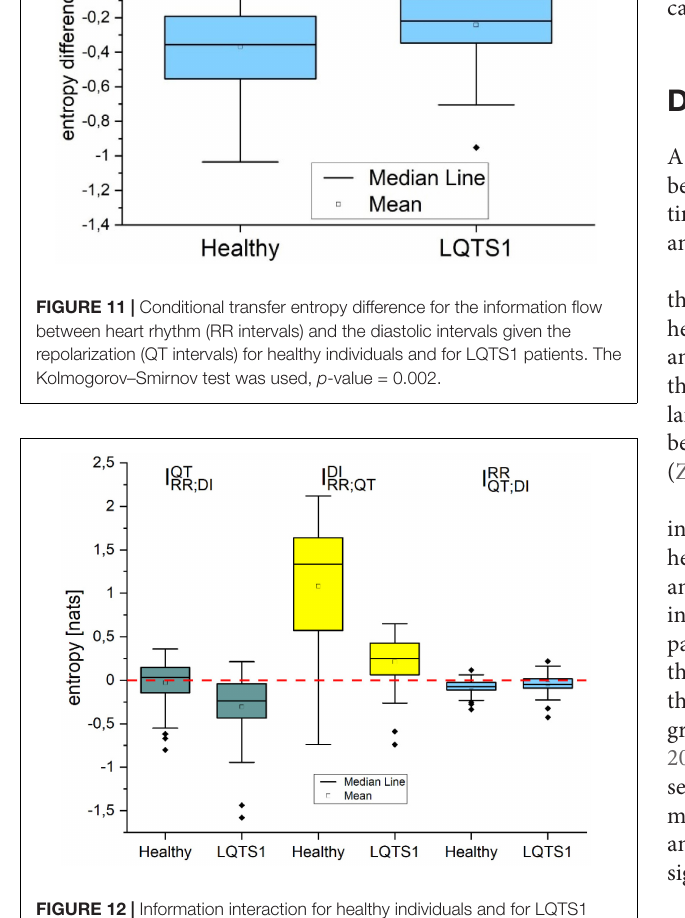
FIGURE 12 | Information interaction for healthy individuals and for LQTS1 patients for three combinations of the variables: RR intervals, QT intervals, and diastolic intervals. The Kolmogorov–Smirnov test was used, p -values: I QT RR ; DI